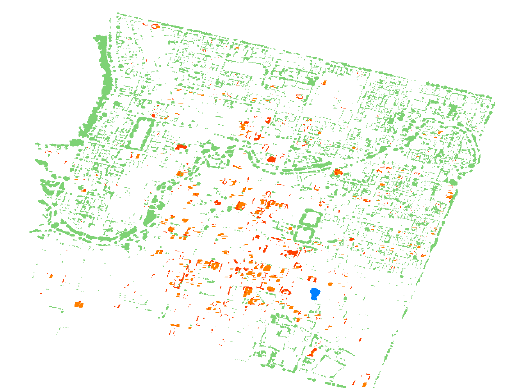
Figure 3 . Workflow of the debris detection Figure 2 . Reference map regarding classes debris (red: ground- level debris, orange: higher-level debris), vegetation (green) and gravel (blue).